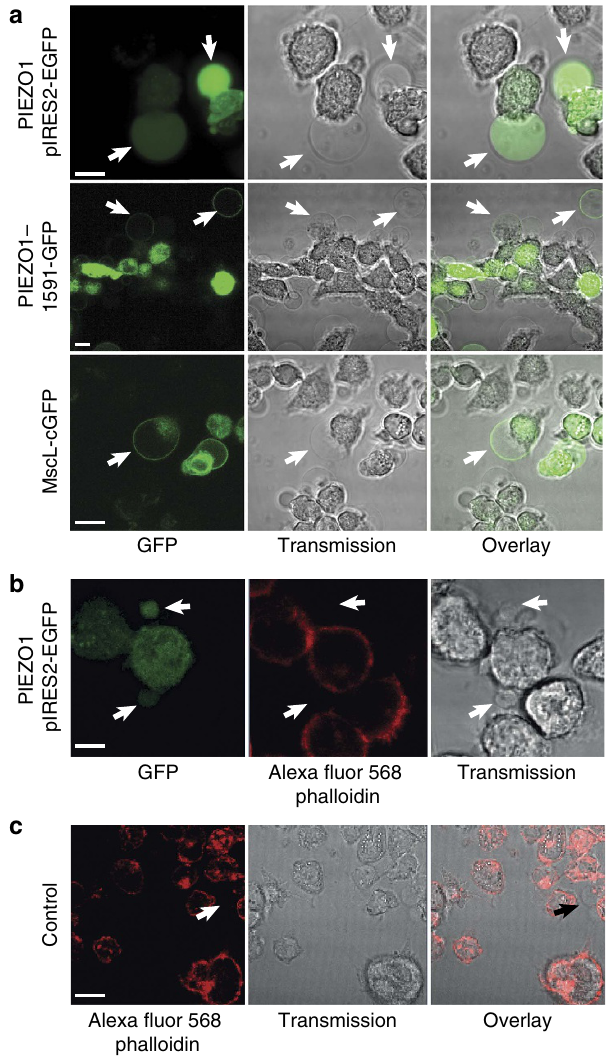
Figure 2 | Fluorescence imaging of HEK293 cell membrane blebs generated using a hypo-osmotic solution. ( a ) Example of pIRES2–EGFP PIEZO1 expression in HEK blebs. The blebs can be clearly seen with free GFP inside the cytoplasm. Blebs sometimes grew to diameters greater than 15 m M (upper row). GFP fusion proteins of PIEZO1 (middle row) and MscL (lower row) can also be seen in the bleb membrane (scale bar, 10 m m). ( b ) Illustration of staining of cells expressing a pIRES2–EGFP PIEZO1 construct. Arrows represent blebs that contain GFP but are devoid of f-actin staining (red; scale bar, 7 m m). ( c ) As a control, we also stained cells blebbed in the same manner and stained with phalloidin. Again, the arrow represents a bleb that is not stained and hence deficient in f-actin (scale bar, 20 m m).